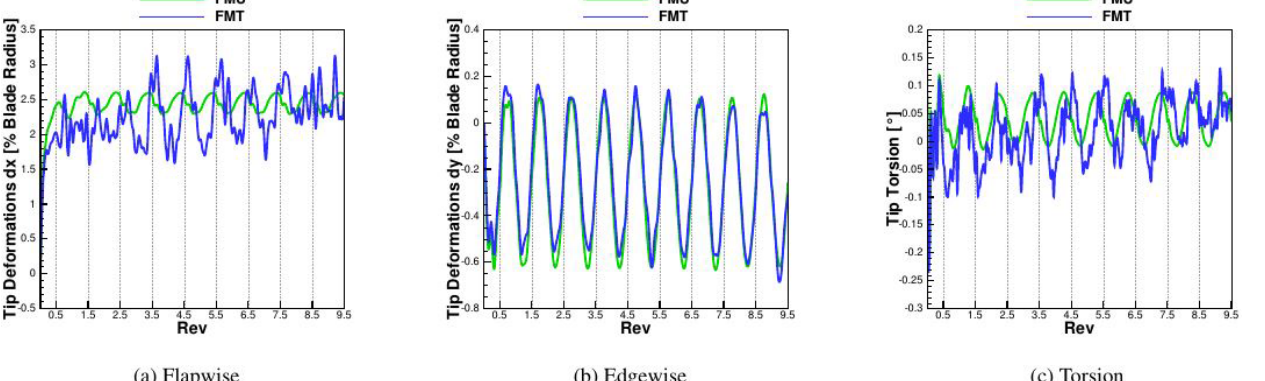
Figure 15. Tip deformations comparing FMU vs. FMT calculated with CFD.